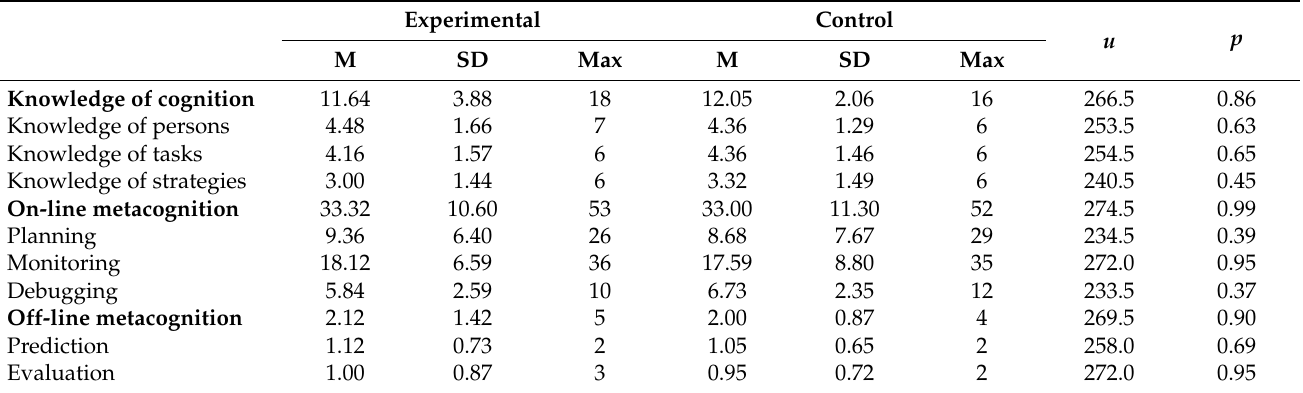
Table 3. The means, standard deviations, and maximum of the metacognition scores and Mann–